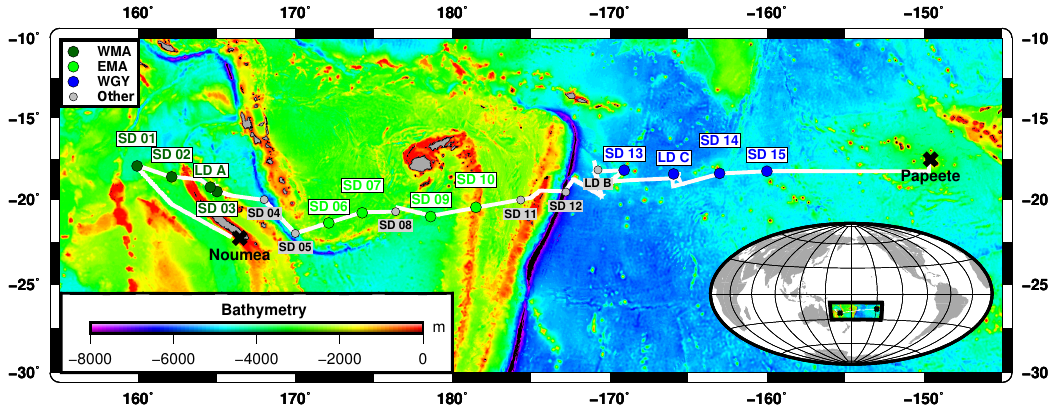
Figure 1. Position of stations during the OUTPACE cruise. The white line shows the vessel route (data from the hull-mounted ADCP positioning system). In dark green WMA (Western Melanesian Archipelago) including SD1, 2, 3 and LDA; in light green, EMA: Eastern Melanesian Archipelago including SD6, 7, 9 and 10 and in blue WGY (Western Subtropical Gyre) including stations SD13, 14, 15 and LDC. Figure courtesy of Thibaut